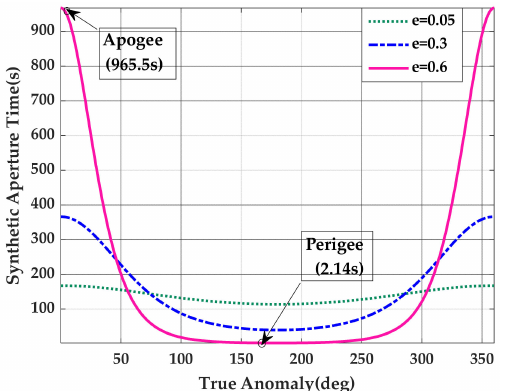
Figure 4. The variation curve of synthetic aperture time under different eccentricity